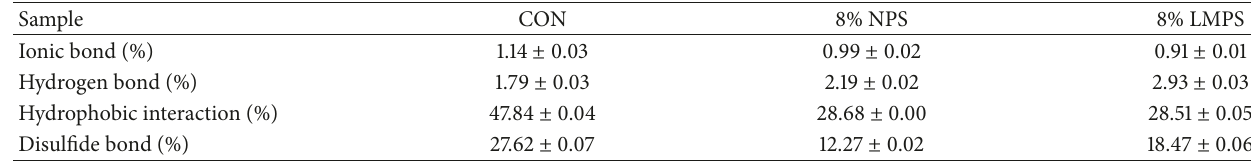
Table 2: Chemical forces of surimi gel